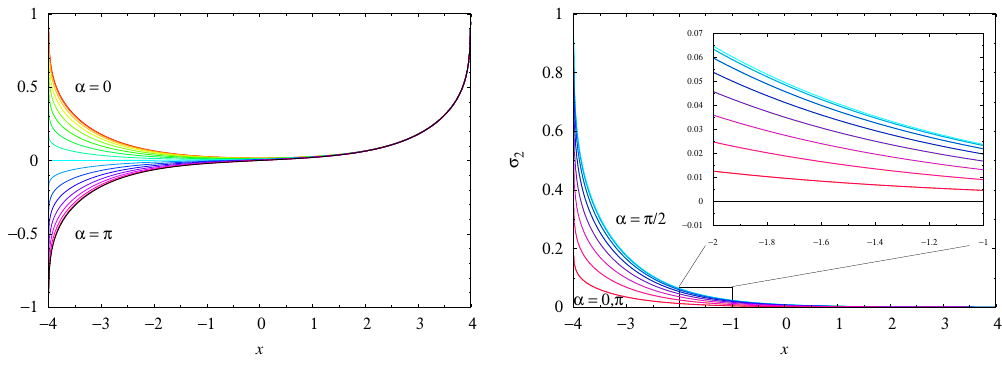
Figure 15. The same as (cid:12)gure 2 but for L = 8.